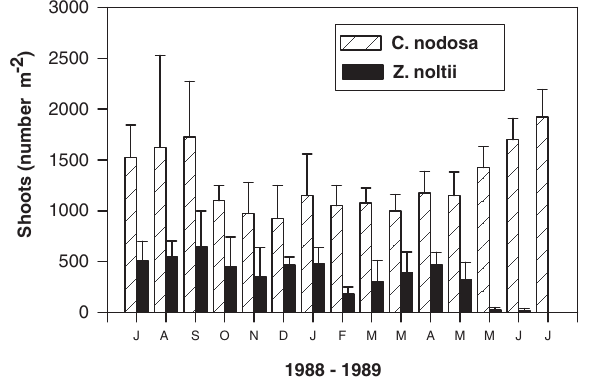
Leaf phenology and dynamics F IG . 3. – Annual variation of shoot density of C. nodosa and Z. noltii In a year, the total mean number of leaves per in the mixed bed off San Pietro (Ischia, Gulf of Naples). Two mea- surements are shown for March and May, due to the increased shoot was 4 ± 0.6, showing a seasonal pattern, with growth rate during the spring period. the highest values in June (6.0 ± 0.6) and the lowest in December (3.0 ± 0.9) (Fig. 4). The number of the two leaf ranks fluctuated seasonally with the maxi- mum values in spring for the undifferentiated leaves and in summer for the others (Fig. 4). The monthly mean lengths of both differentiated (sheath included) and undifferentiated leaves T ABLE 1. – Fruits, seeds and seedlings densities in the C. nodosa showed maximum values in summer (40.3 ± 12.2 meadow of Ischia. cm and 17.0 ± 6.7 cm respectively), whereas the minimum was recorded in December (7.0 ± 1.3 cm)